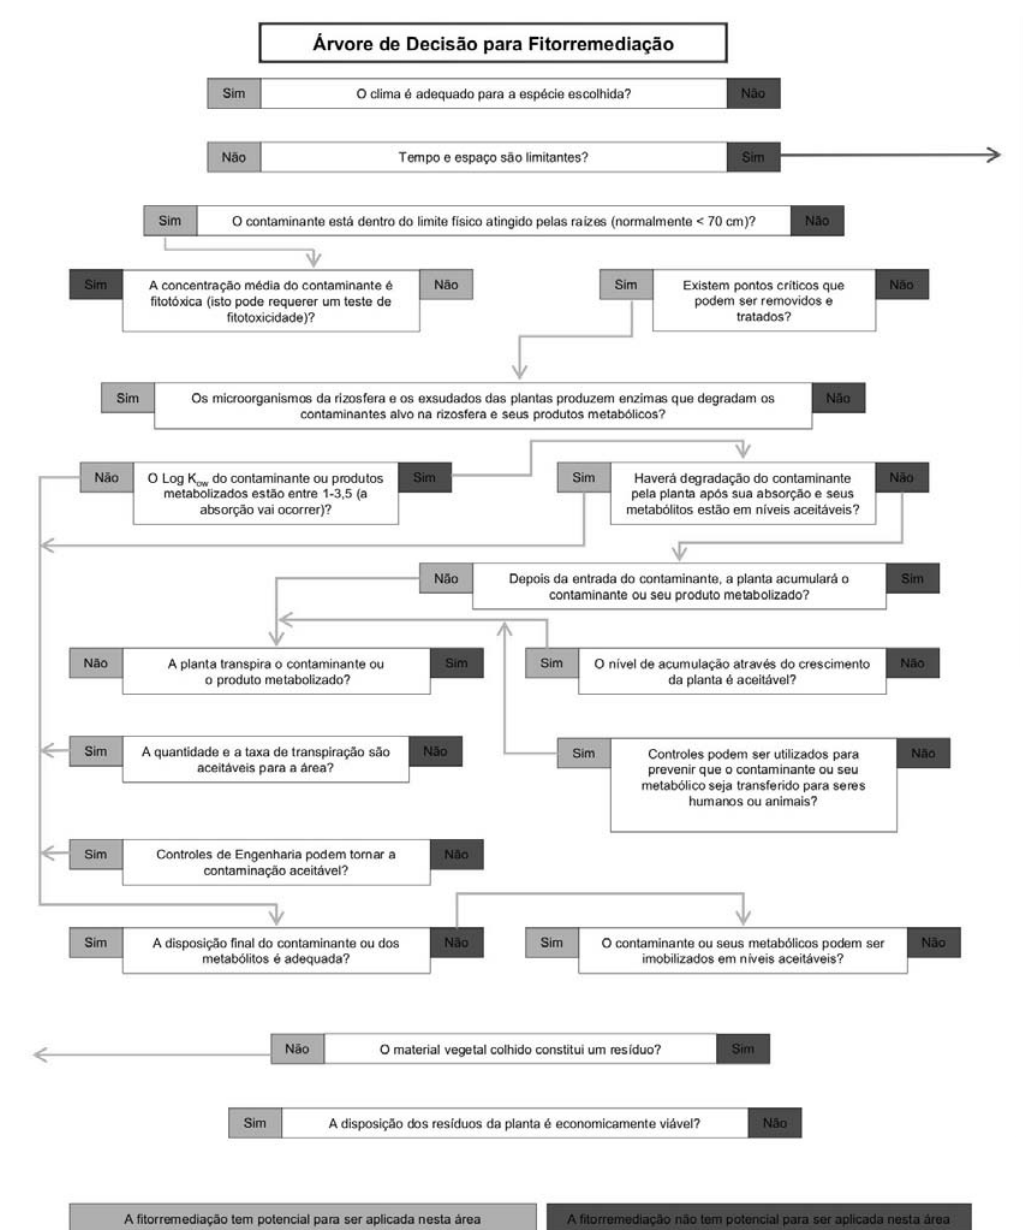
Figura 2. Fluxograma de árvore de decisão para verificação da fitorremediação de solos contaminados como opção técnica a ser escolhida (adaptado de USEPA,